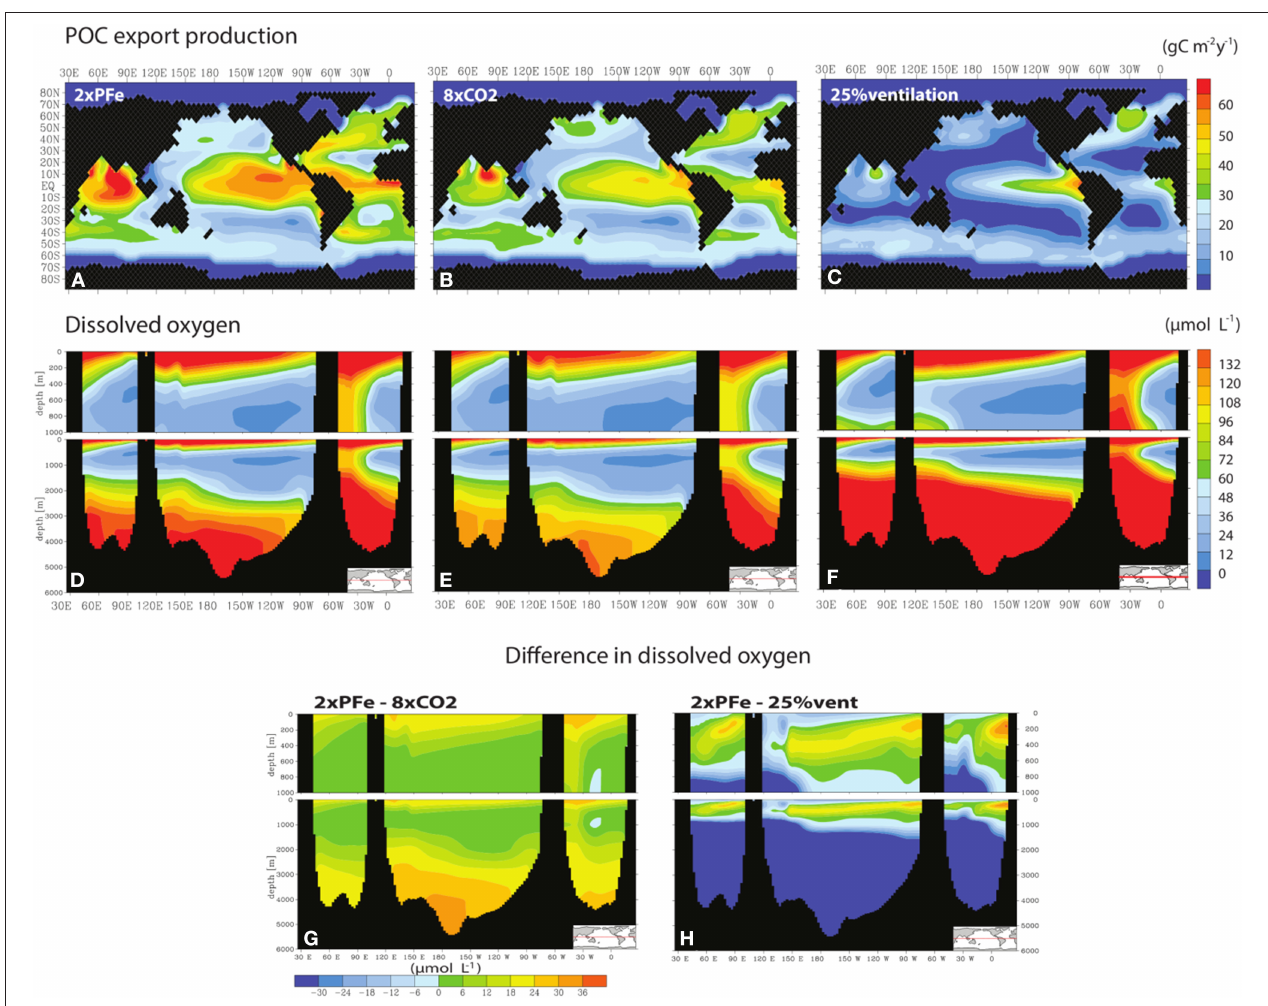
FIGURE 4 | POC export production (A–C) and dissolved oxygen concentrations (D–F) after 10 kyrs for our scenario with a doubling of nutrients (2xPFe) and 2 scenarios of Beaty et al. (2017): one with a 8x increase in CO 2 radiative forcing (8xCO2) and one with a reduction of 25% in the ocean ventilation (25%vent). Difference in oxygen concentrations (G,H) between our scenario and those of Beaty et al. (2017). Positive values indicate that changes in nutrient-driven oxygen demand are smaller than those in temperature- or ventilation-driven oxygen supply, hence allowing higher concentrations of oxygen to remain. Negative values indicate the